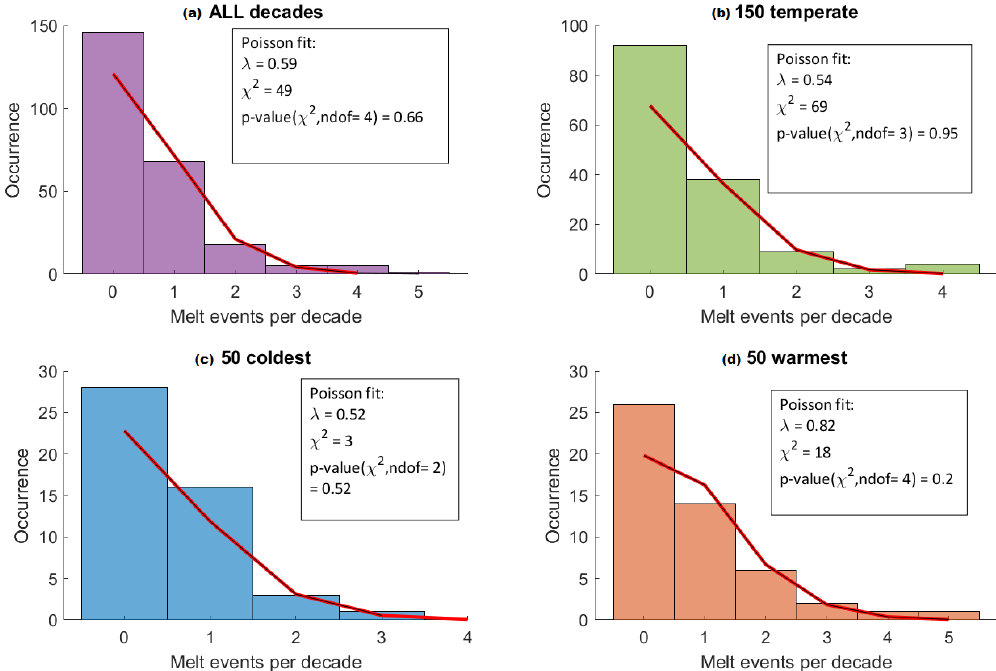
Figure A7. Histograms of melt events per decade over the last 2500 years. To highlight the correlation between melt and Northern Hemi- sphere temperatures, we distinguish between cold, warm, and temperate decades ( b , c , and d , respectively). We fit the occurrence of melt per decade to Poisson distributions and obtain satisfactory p -values. The warmest decades (d) show an occurrence of melt that is 18% higher than the general value (a) . Melt in cold decades is not substantially different from the temperate value.